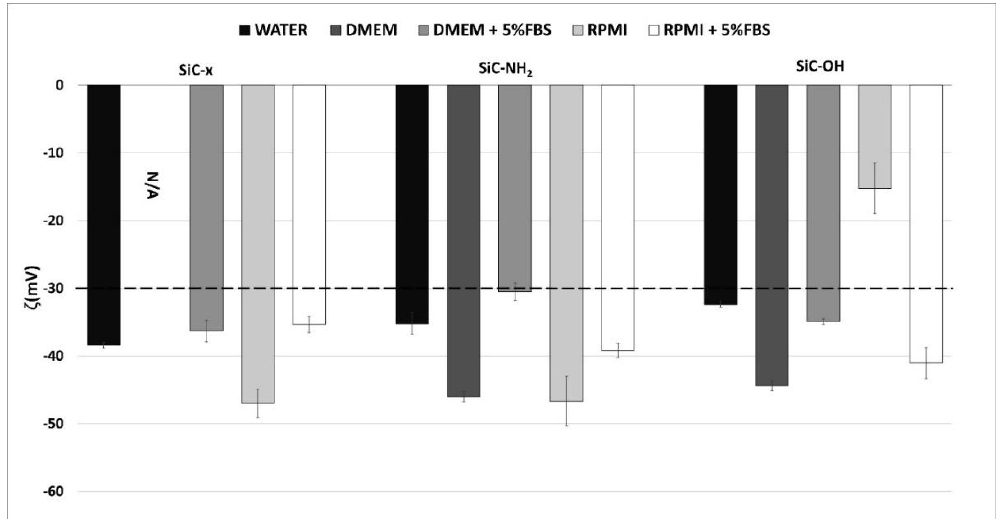
Figure 2. Value of ζ for the SiC-based NPs in different solutions. Parameter ζ was measured on NPs in water, DMEM and RPMI 1640 with and without the addition of 5% FBS.